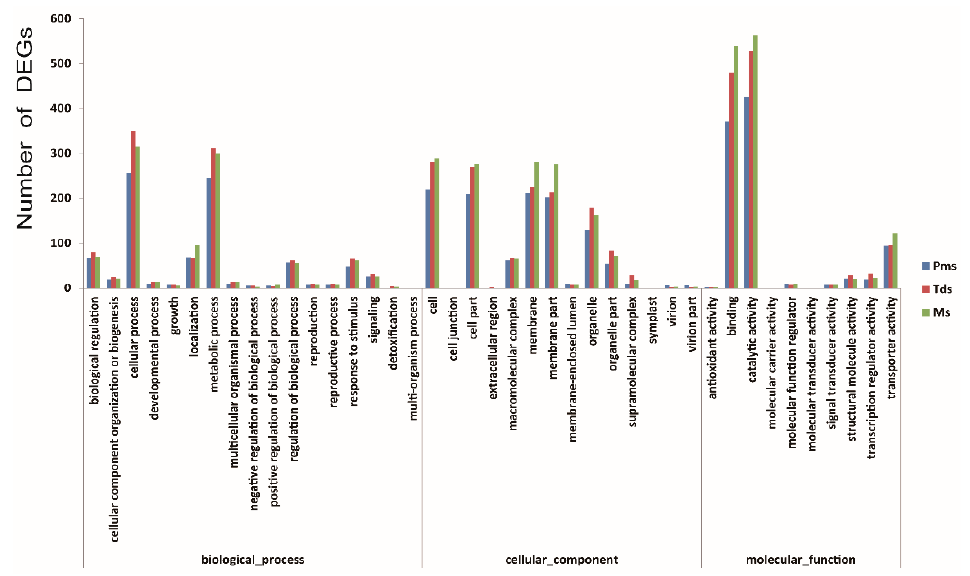
Figure 5. GO function enrichment of DEGs between the C2P5A and the C2P5B from the Pms to Ms stage of anther development. Pms, pollen mother cell stage; Tds, tetrad stage; Ms, mononuclear stage.